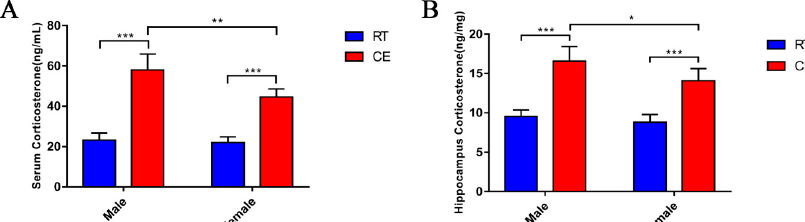
Figure 1. Serum and hippocampus tissue cortisol (CORT) levels of male and female mice at room temperature male (RTM), cold exposure male (CEM), room temperature female (RTF), and cold exposure female (CEF) mice. Data analyses in different treatment ( A ) and sex groups ( B , C ) by two- way ANOVA. Results are expressed as the mean ± SD ( n = 10) in ten independent experiments. N.S.: not significant; * p < 0.05, ** p < 0.01, *** p < 0.001.